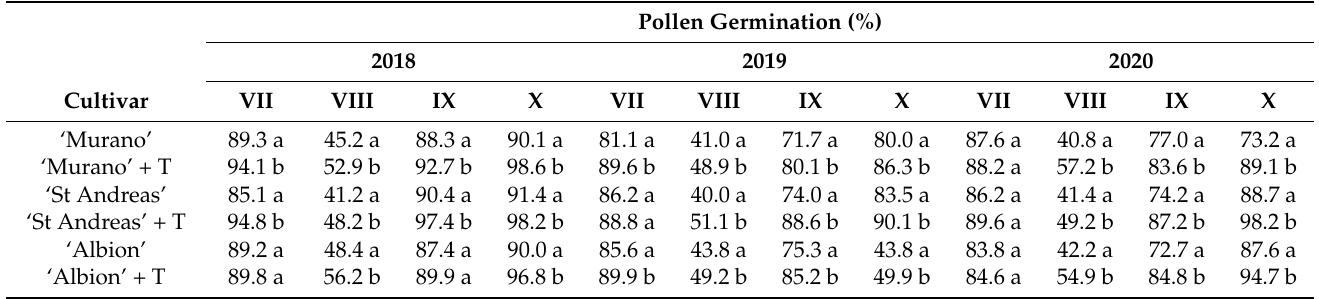
Table 2. The effect of titanium organic complex on the germination of pollen grains of three strawberry cultivars